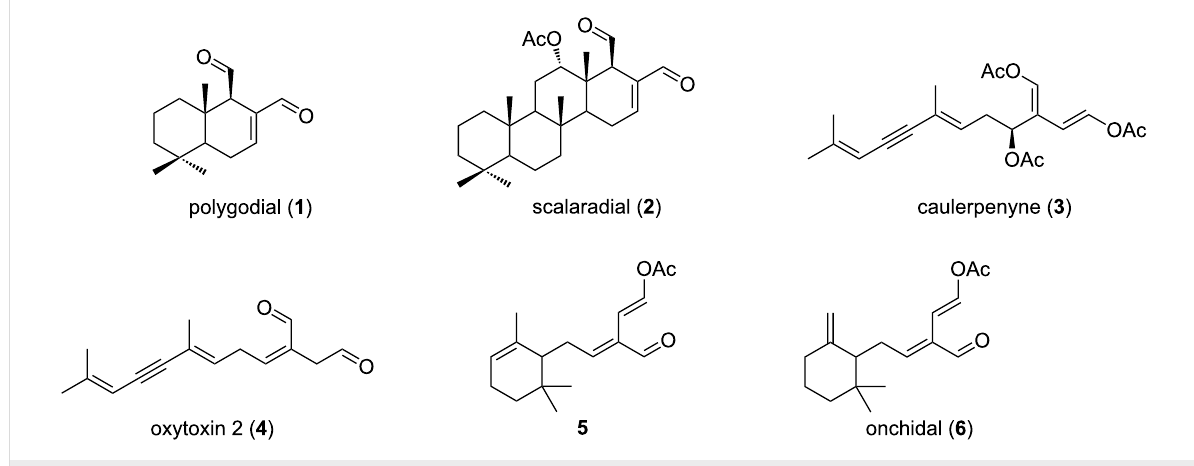
Figure 1: Masked and unmasked 1,4-dialdehyde natural products 1 – 6 .